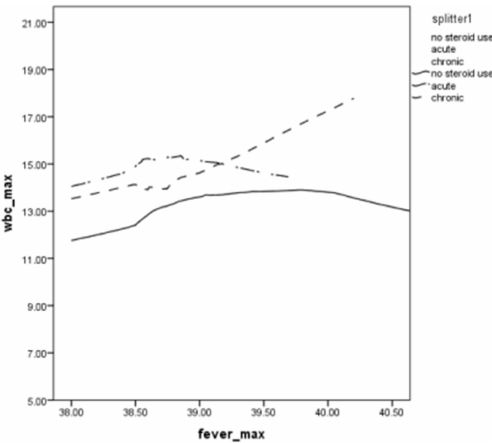
Figure 1. Maximum WBC count as a function of maximum body temperature for COPD patients receiving acute steroid treatment, chronic steroid treatment or no steroid treatment. Table 3. Linear regression model for the prediction of maximal white blood cell (WBC) count within 24 h from admissions. Variable Unstandardized